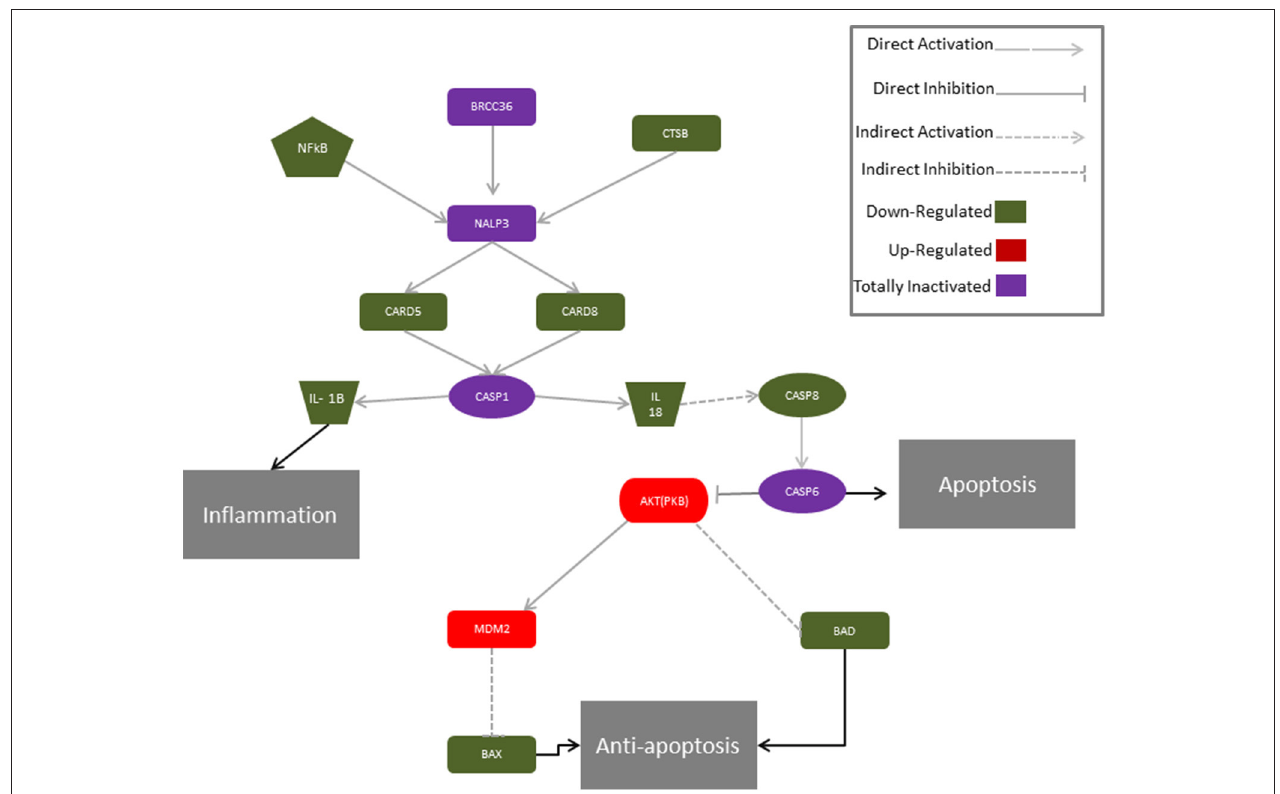
FIGURE 6 | Proposed molecular mechanism for CBD modulation of the genes of the NALP3-inflammasome in hGMSCs. The activation of the NALP3-inflammasome is regulated by NF-kB which promotes NALP3 deubiquitination via activation of BRCC36. NALP3 interacts with CASP1 through CARD5 and CARD8. Activated CASP1 cleaves pro-IL-1 beta and pro-IL-18, leading to subsequent release of mature cytokines which trigger inflammation. In parallel, IL-18 indirectly via CASP8 and CASP6 can stimulate apoptosis. In hGMSCs, BRCC6, NALP3 and CASP1 transcripts are suppressed (violet) and the expression of